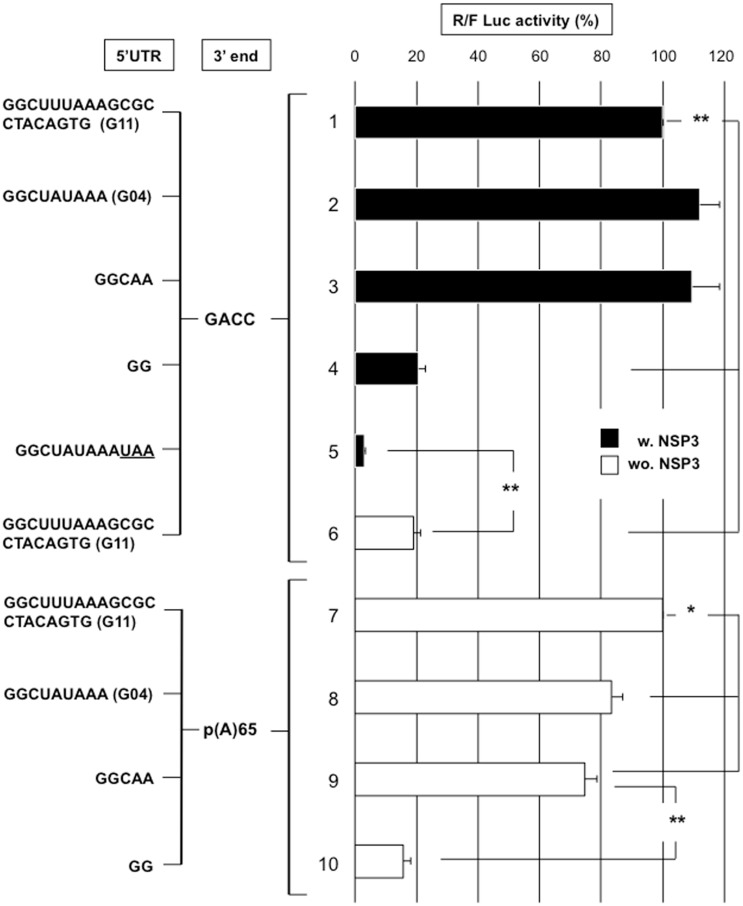
The importance of the 5'UTR length in NSP3- and poly(A)-dependent translation.BSRT7 cells expressing NSP3 (NSP3; black bars) or no NSP3 (NSP3-KO) (wo. NSP3; white bars) were electroporated with the indicated capped R-RNA molecule (lines 1–6) or capped -p(A)-RNA molecule (lines 7–10) and the standard RNA. The Renilla and firefly luciferase activities were measured 6 hours after electroporation. The Renilla to firefly luciferase ratio is relative to the controls (lines 1 and 7), which was considered 100. The nucleotide sequence upstream the AUG initiation codon is indicated and the 3’UTR is from gene 11. The data are the mean ± SEM of three independent experiments in triplicate. A Student’s t-test was used (*p<0.05;**p<0,01).